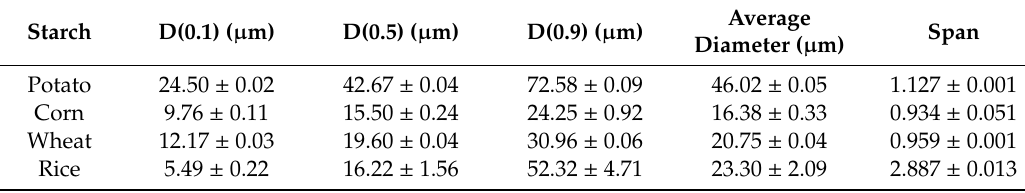
Table 1. Particle size analysis of potato, corn, wheat, and rice starches.